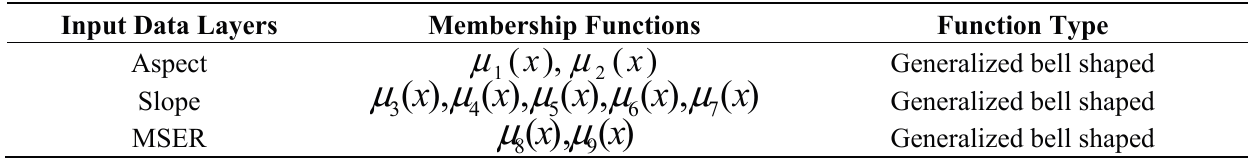
Figure 10. The proposed Adaptive Neuro Fuzzy Inference System (ANFIS) network. Table 4. Membership functions for input data layers.